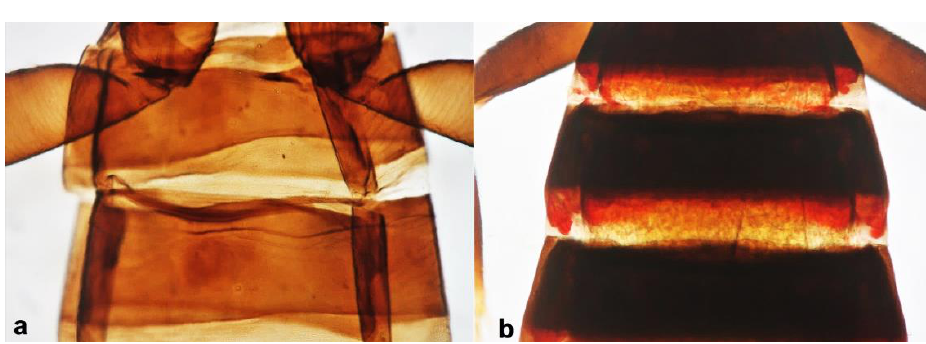
10 Internal body colour orange brown (Figure 11a); females macropterous. On Stipa capen- Internal body colour often carmine red (Figure 11b); females can be macropterous or micropterous (Figure 10g). On different species of Poaceae ......................................... 11